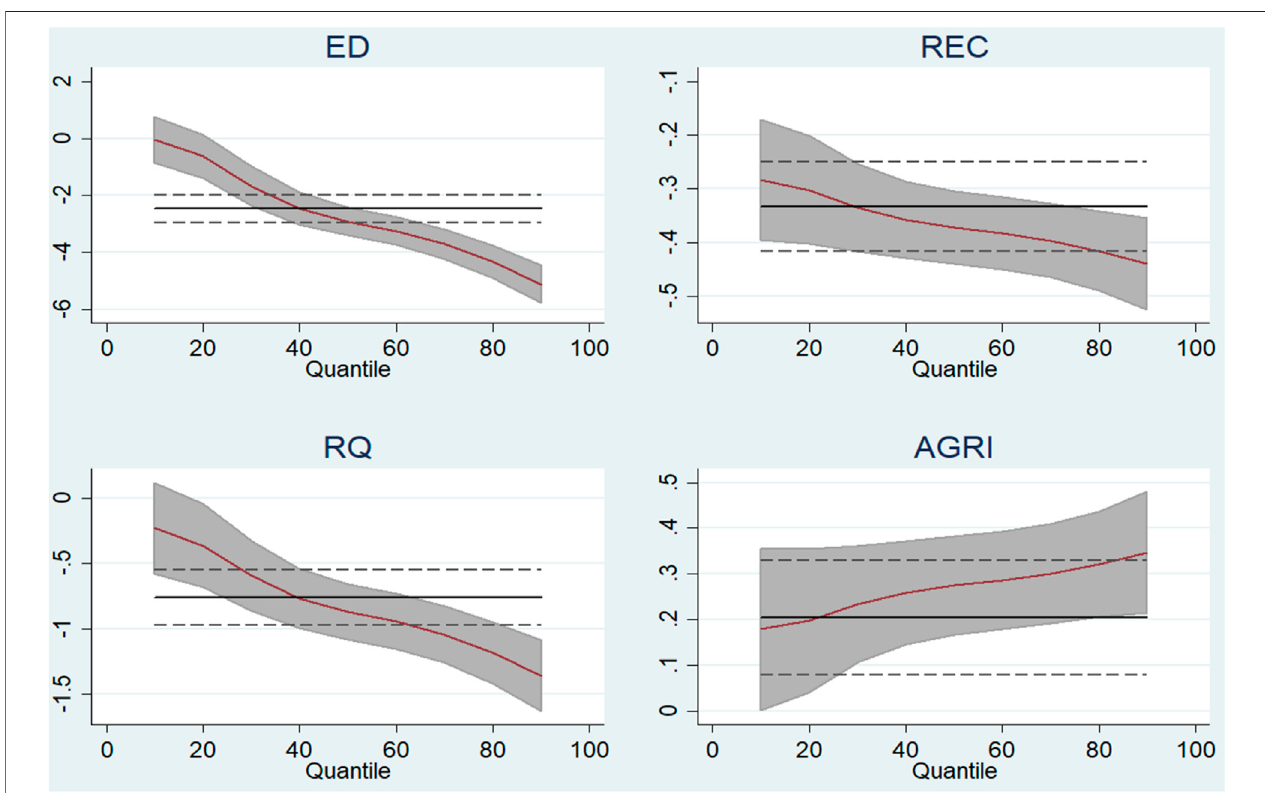
FIGURE 2 | Plotting parameters across quantiles in